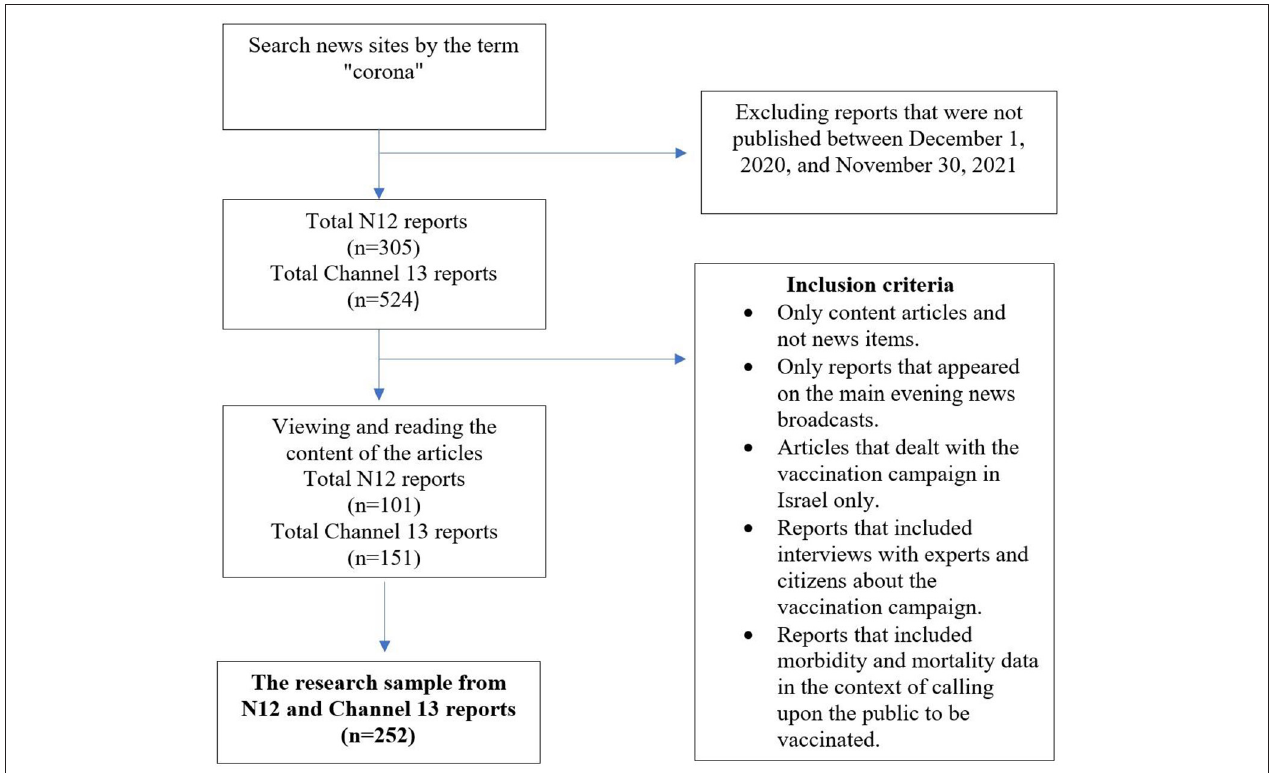
FIGURE 1 | Sampling